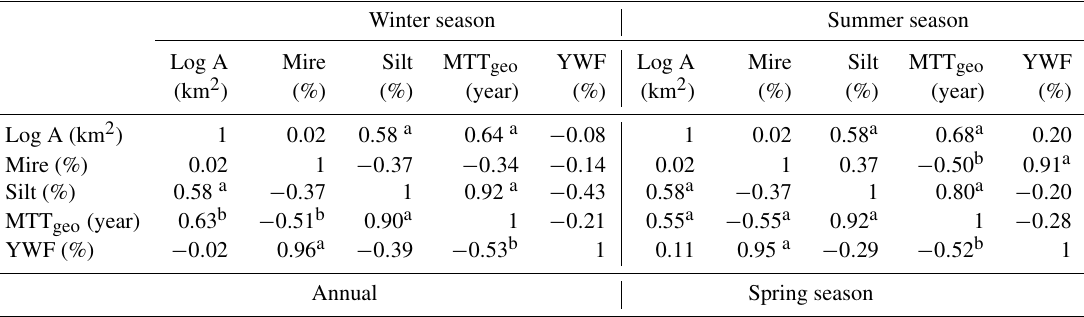
Table 6. Correlation matrix – young water fraction (YWF), geometric mean travel time (MTT geo ), and catchment characteristics . The table includes annual, winter, spring, and summer